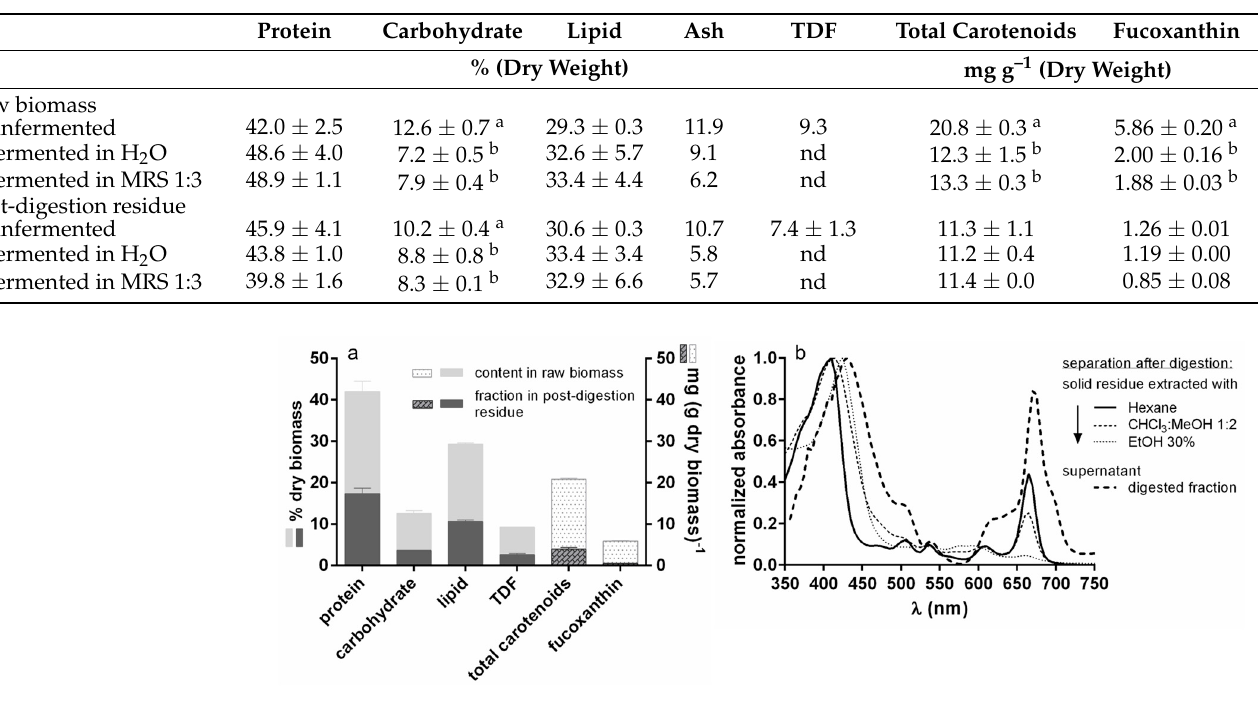
Table 2. Biochemical composition of T. lutea F&M-M36 biomasses and digested residues. Content in protein, carbohydrate, lipid, and total dietary fibres of raw biomass and post-digestion residue, unfermented and fermented. Data are expressed as mean ± standard error. Superscript letters indicate significant differences ( p < 0.05) between unfermented and fermented samples within the same starting material. TDF, total dietary fibres; nd, not determined.